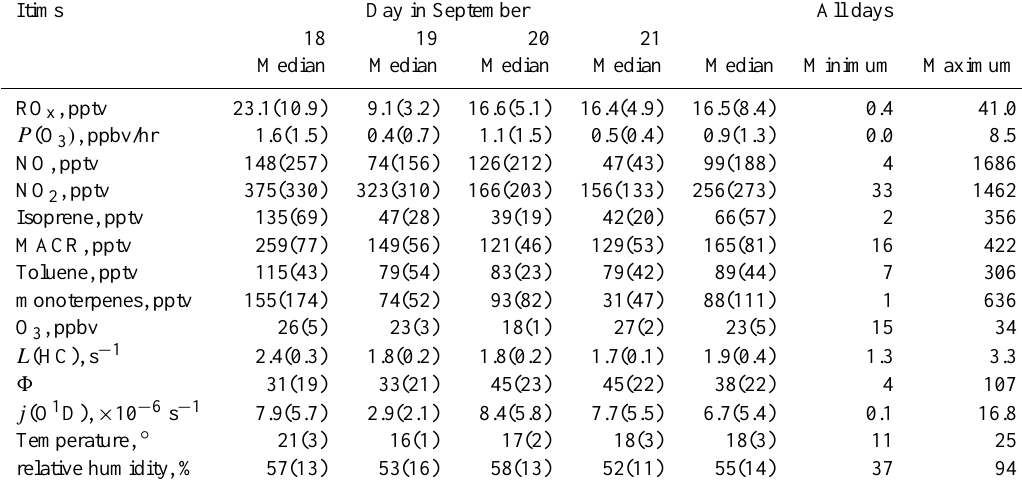
Table 1. Summary of observed P (O 3 ) and selected chemical species and parameters (1 σ standard deviation given in brackets). Itims